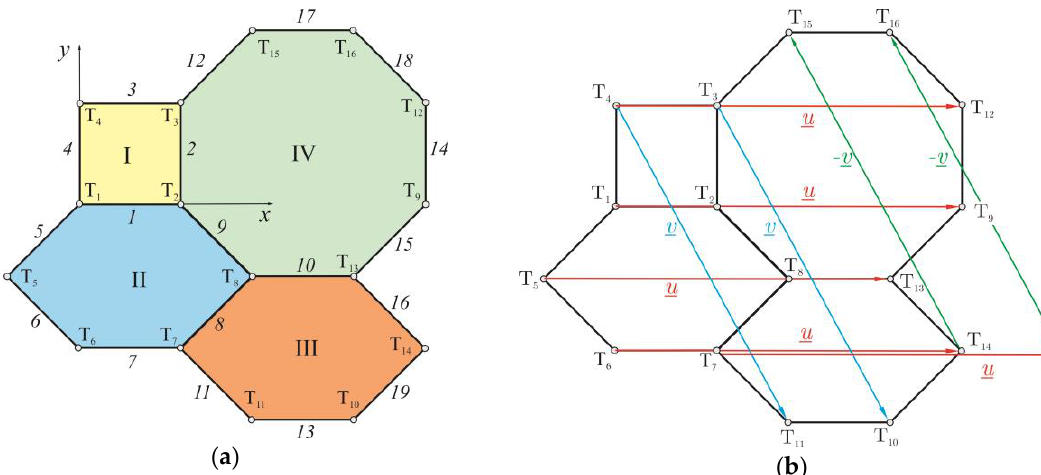
Figure 1. Initial arrangement of the “unit cell” of the grains. ( a ) The four grains are labelled by Roman numerals I-IV. The triple points are denoted as T 1 - T 16 . The grain boundaries are labelled by Arabic numerals in italics 1-19. ( b ) The displacement vectors u and v are used to construct the triple points T 9 –T 16 from triple points T 1 –T 7 .